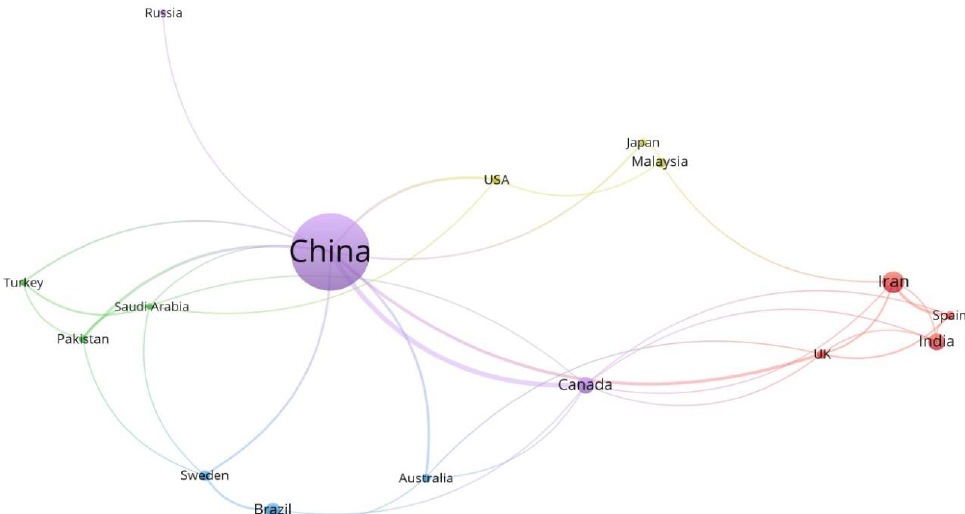
Figure 3. A diagram showing the international collaboration network of oily sludge research. Only countries with more than five articles are included in the statistical analysis. The larger the size of the circle, the higher the number of citations; circles with the same color indicate more frequent collaboration among the countries .